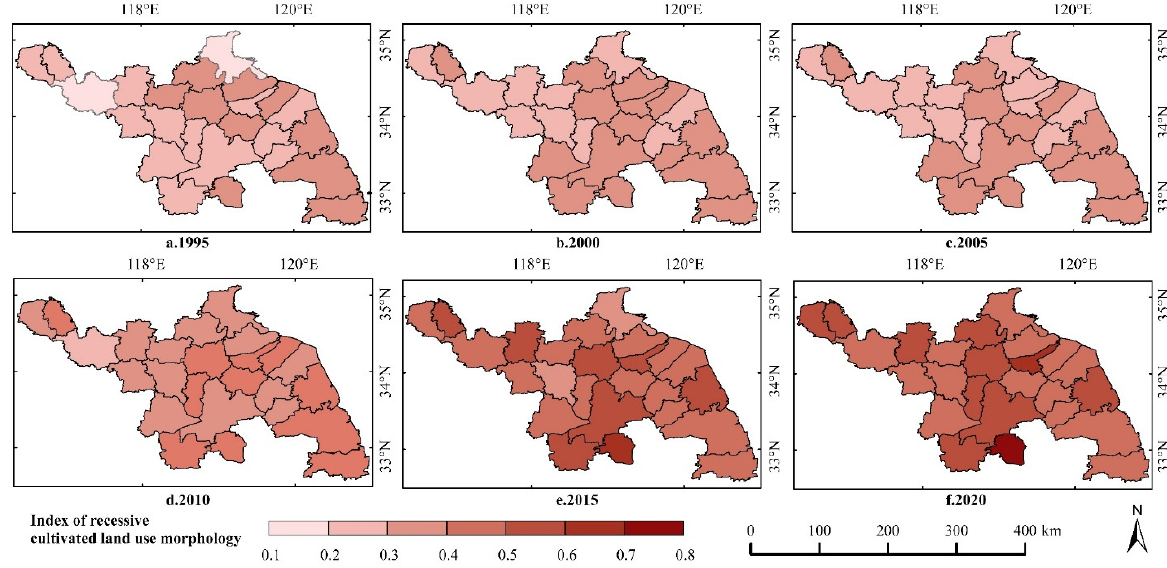
Figure 3. Spatial distribution of the index of recessive cultivated land use morphology.